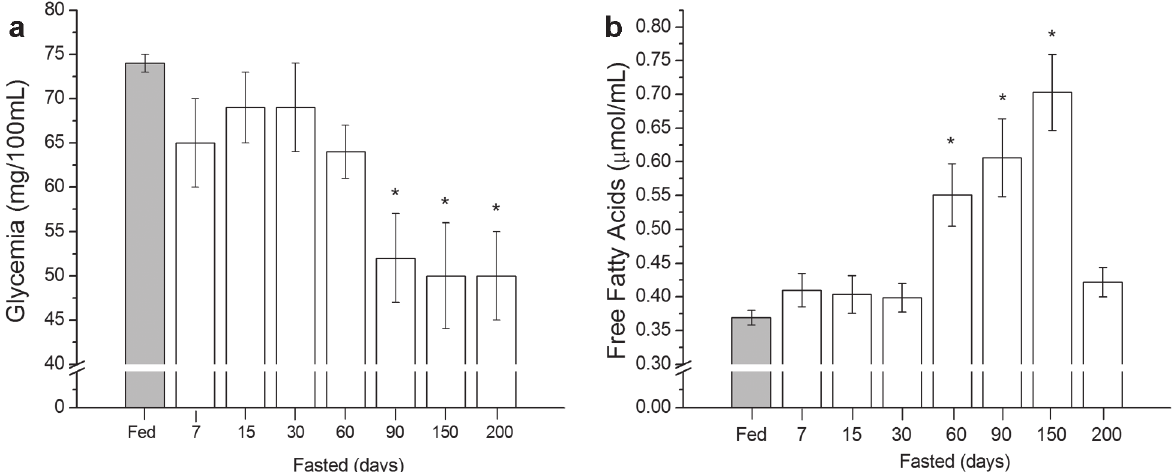
figure 1 - Plasma metabolic parameters of fed and fasted red tilapia ( Oreochromis sp). Glycemia (a) and free fatty acids (b) were evaluated. Values represent mean ± SEM (n=10 fishes for fed and for each fasting period). *(P<0.05) vs fed.